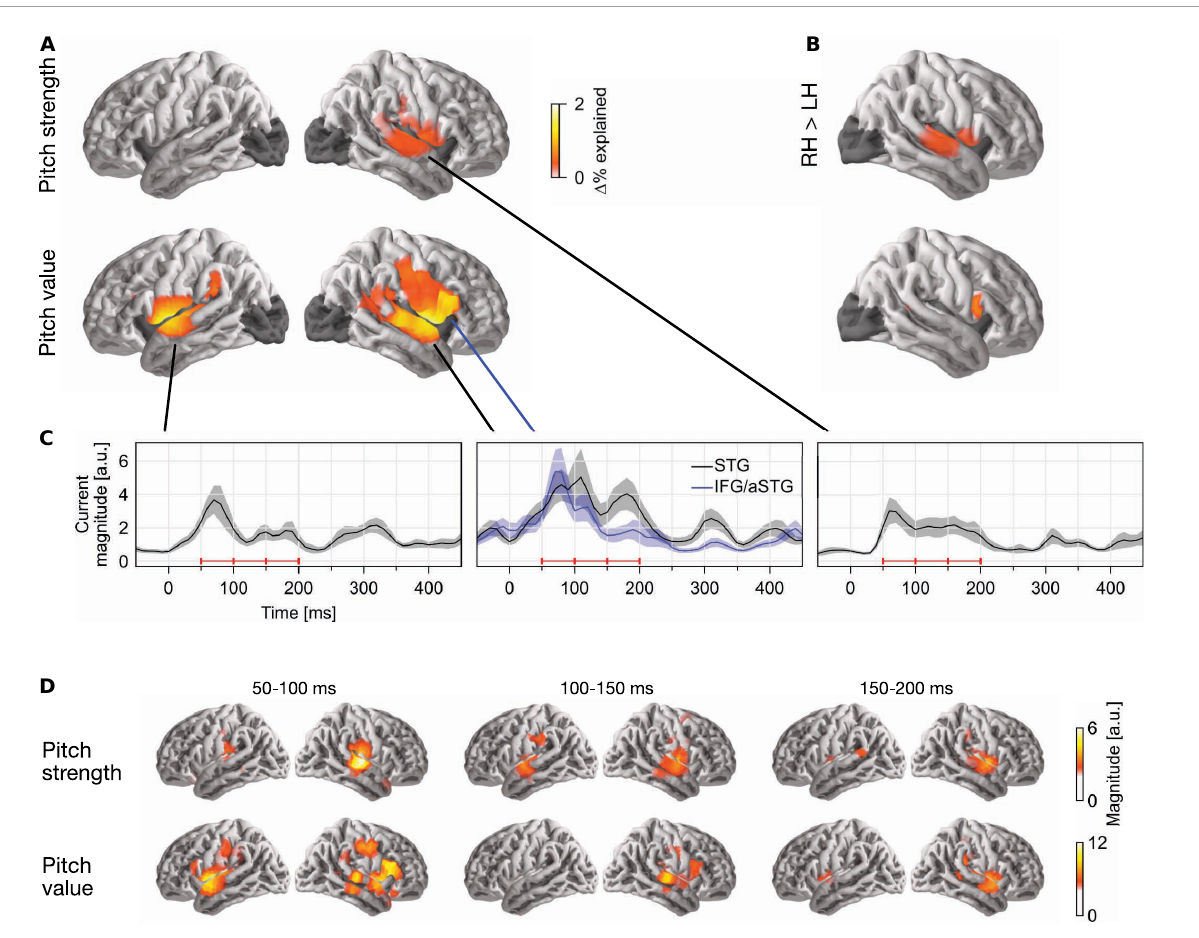
FIGURE2 Separable tracking of pitch strength and pitch value of a single talker. (A) Pitch strength and pitch value both improved model predictions independently, when controlling for acoustic envelope and onset spectrograms ( p ≤ 0.05, corrected; darkened areas excluded from analysis). The color scale reflects the explained variability in MEG responses, expressed as % of the complete model. (B) Both pitch predictors showed some right lateralization. The plots show the right–left hemisphere predictive power difference, same scale as (A) . (C) Temporal response functions (TRFs) showed dominant responses at latencies between 50 and 200 ms. TRF magnitude is shown for regions of significant model prediction. The three horizontal red bars indicate time windows used in (D) . (D) Anatomical distribution of TRFs in 50 ms time windows. LH, left hemisphere; RH, right hemisphere; STG, superior temporal gyrus; IFG, inferior frontal gyrus; aSTG, anterior